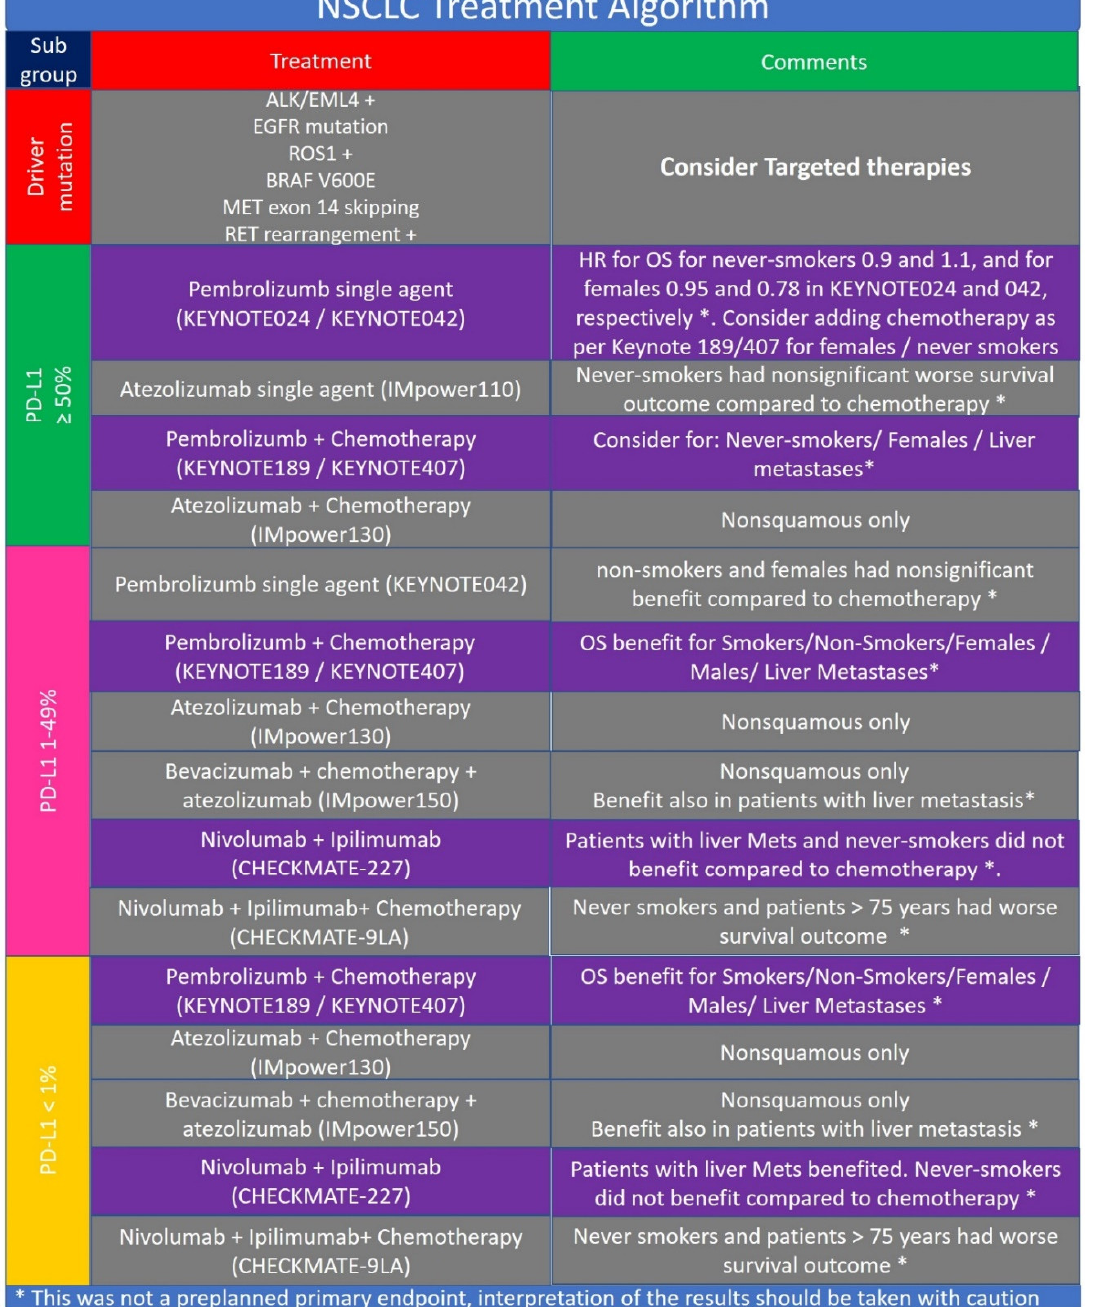
Figure 5. Algorithm for treatment of patients with non-small cell lung cancer (NSCLC).